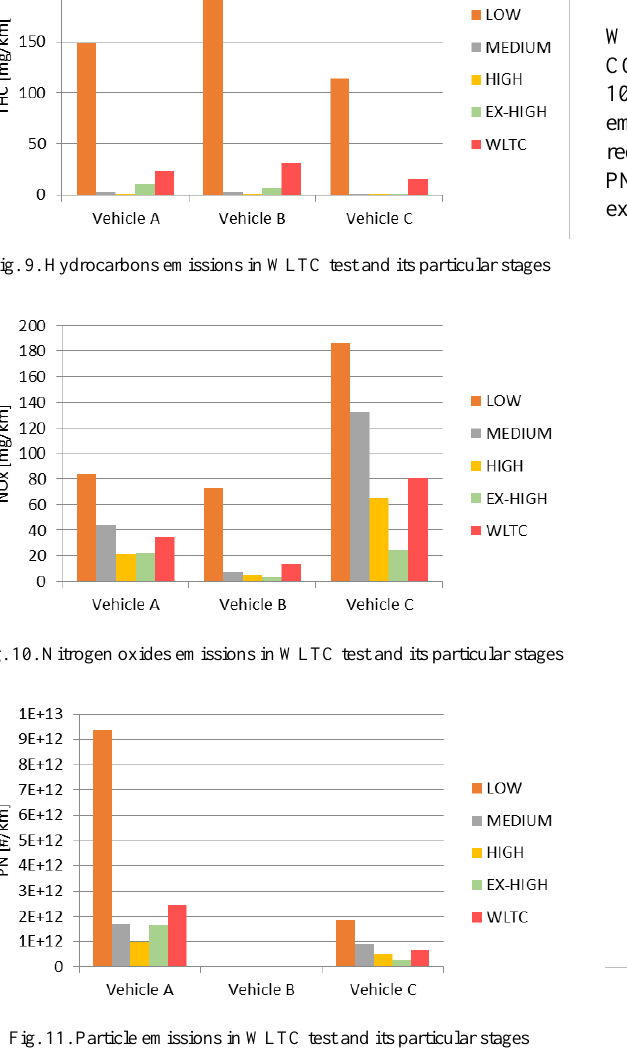
Fig. 11. Particle emissions in WLTC test and its particular stages